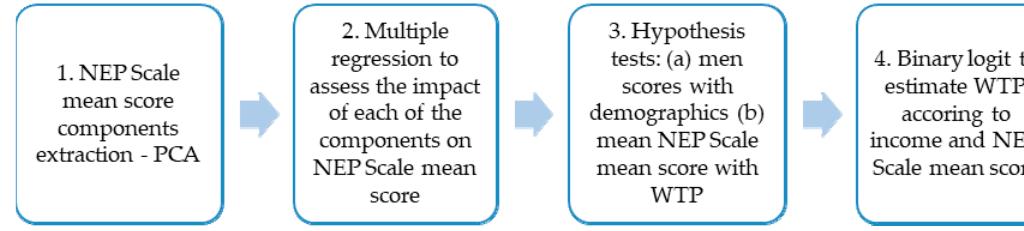
Figure 3. Presentation of the steps included in the results section.